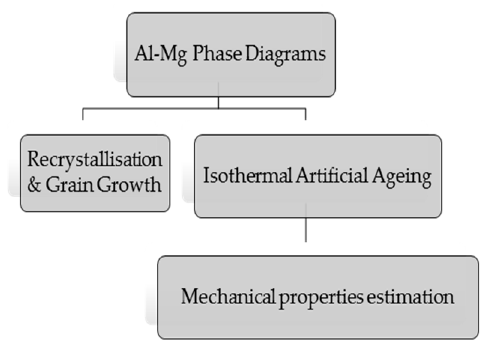
Figure 1. Simulation procedure analysis.